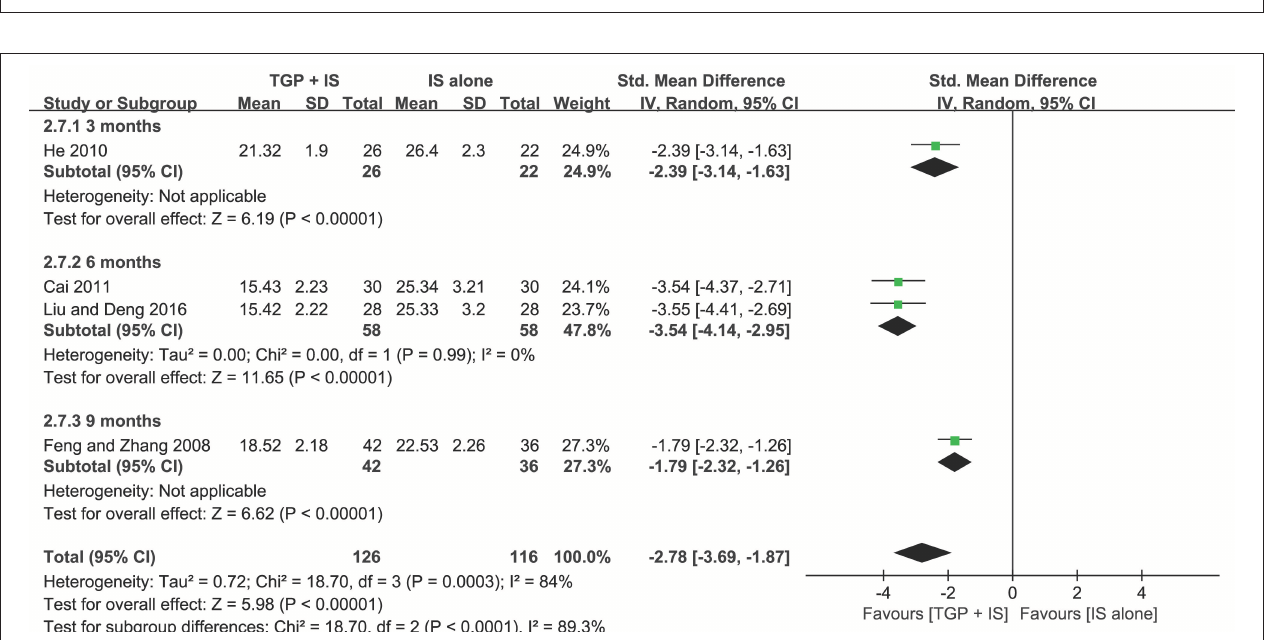
FIGURE 6 | Subgroup analysis of ESR based on intervention duration of TGP + IS vs. IS alone.